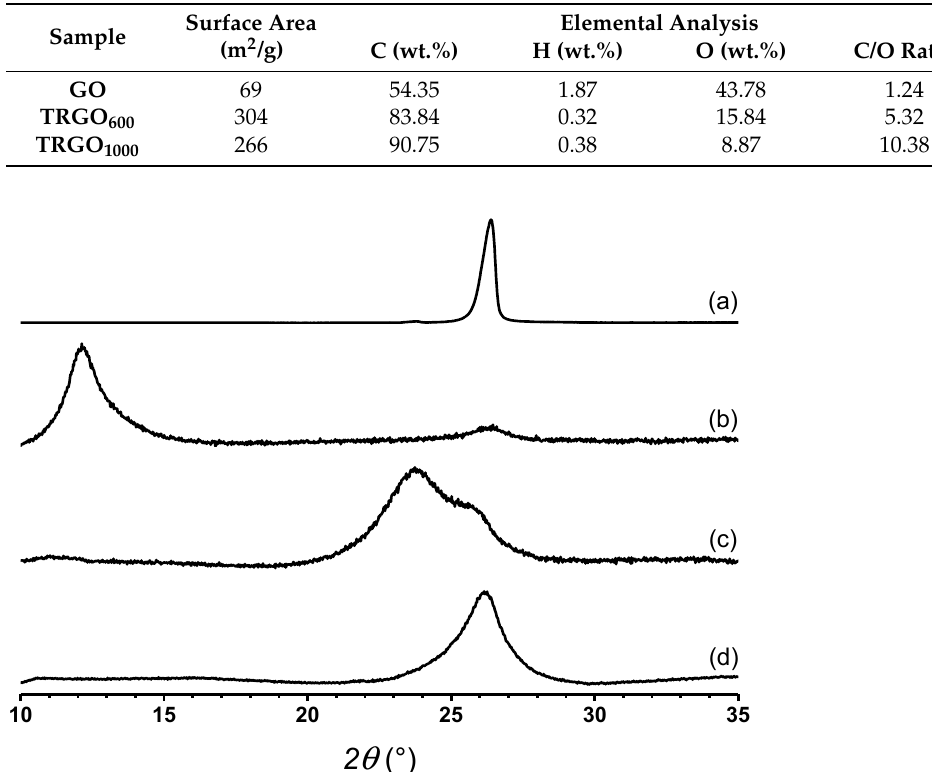
Table 1. BET surface area and elemental compositions of different carbon-based nanomaterials.